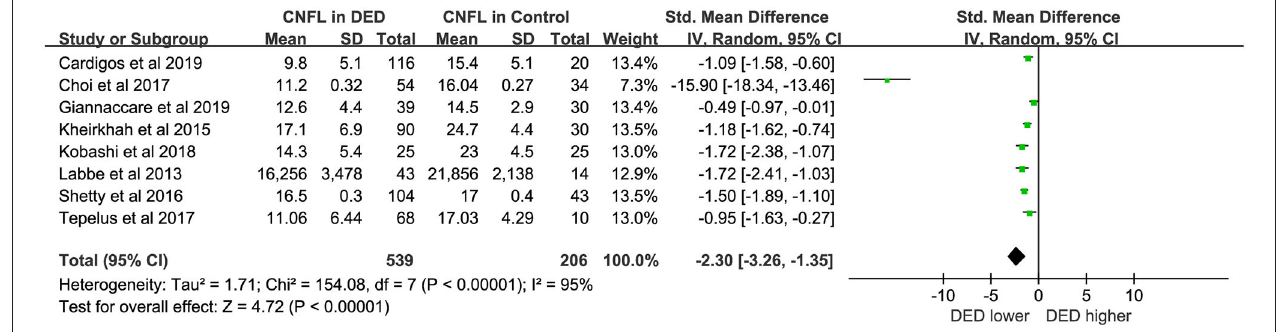
FIGURE 4 | Meta-analysis forest plot of CNFL in DED patients vs. control